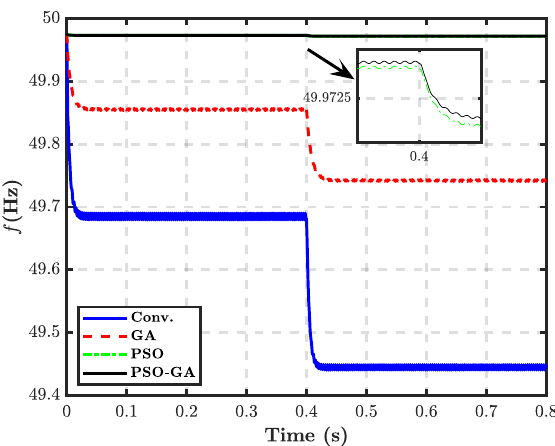
Figure 21. Evolution of the frequency of the islanded MG under nonlinear load